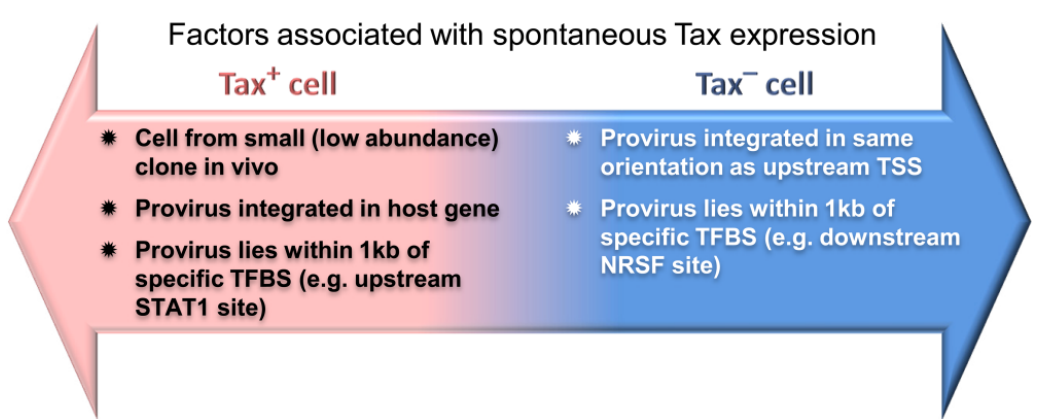
Figure 2. Factors associated with spontaneous HTLV-1 Tax expression in culture.